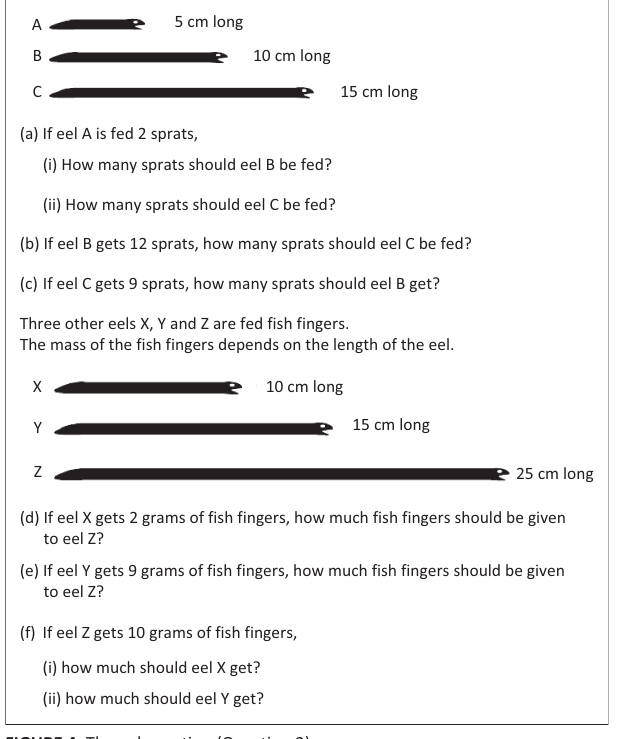
FIGURE 4: The eel question (Question 2). FIGURE 6: Response of Learner 17 to Question